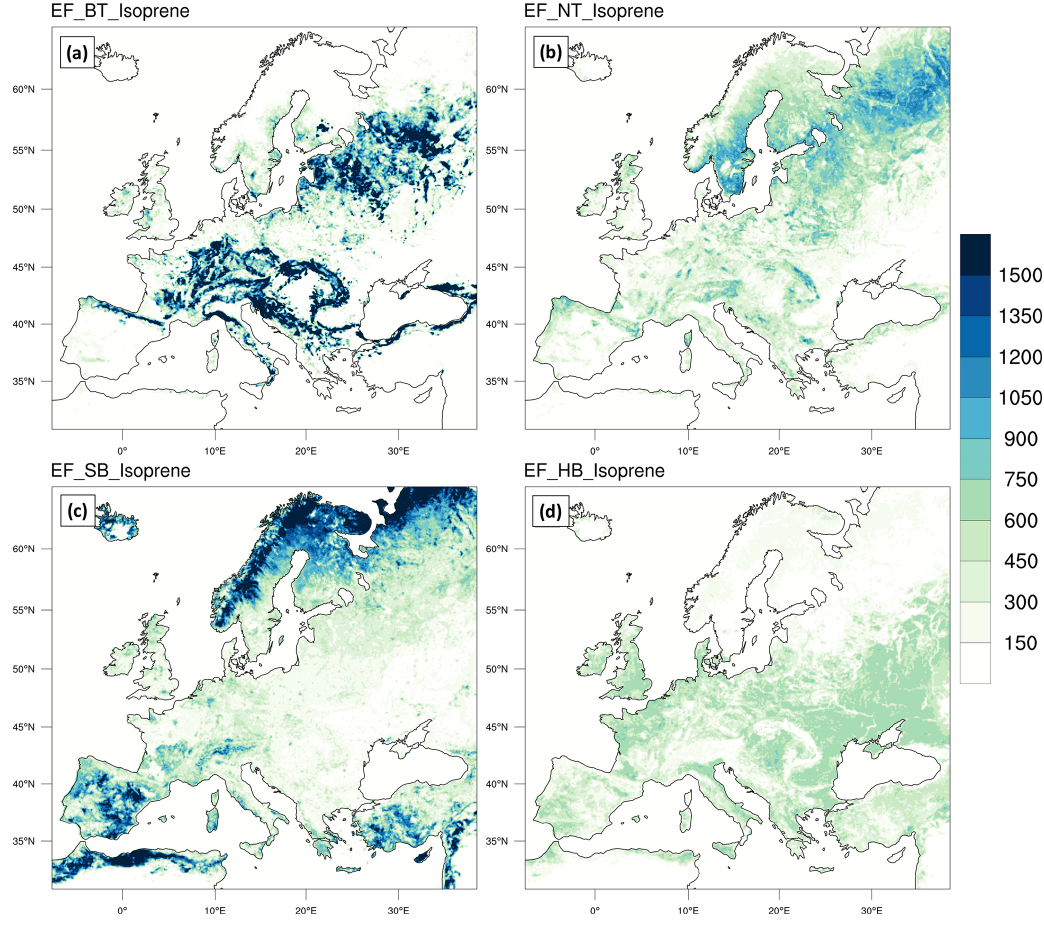
Figure 8. PFT-weighted emission factor (PFT emission factor and PFT percentage) (µgkm − 2 h − 1 ) of isoprene, computed for the month of August 2015 in Europe. The emission factor values used are from Table 2 (2.10 column). From the upper left map: (a) PFT-weighted emission factor of broadleaf trees (PFTP_BT), (b) needleleaf trees (PFTP_NB), broadleaf shrubs (PFTP_SB), and (d) grass and other